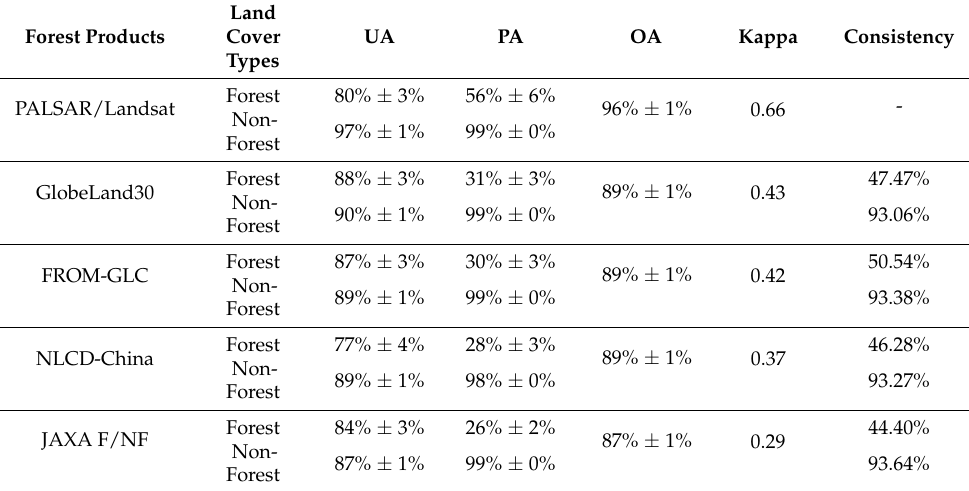
Table 2. Accuracy assessment and consistency of PALSAR/Landsat-based map and the other four forest products in 2010. The consistency refers to the ratio of the number of mutual forest (or non- forest) samples to the total number of forest (or non-forest) samples in Figure 5a. Accuracy measures are adjusted and presented by a 95% confidence